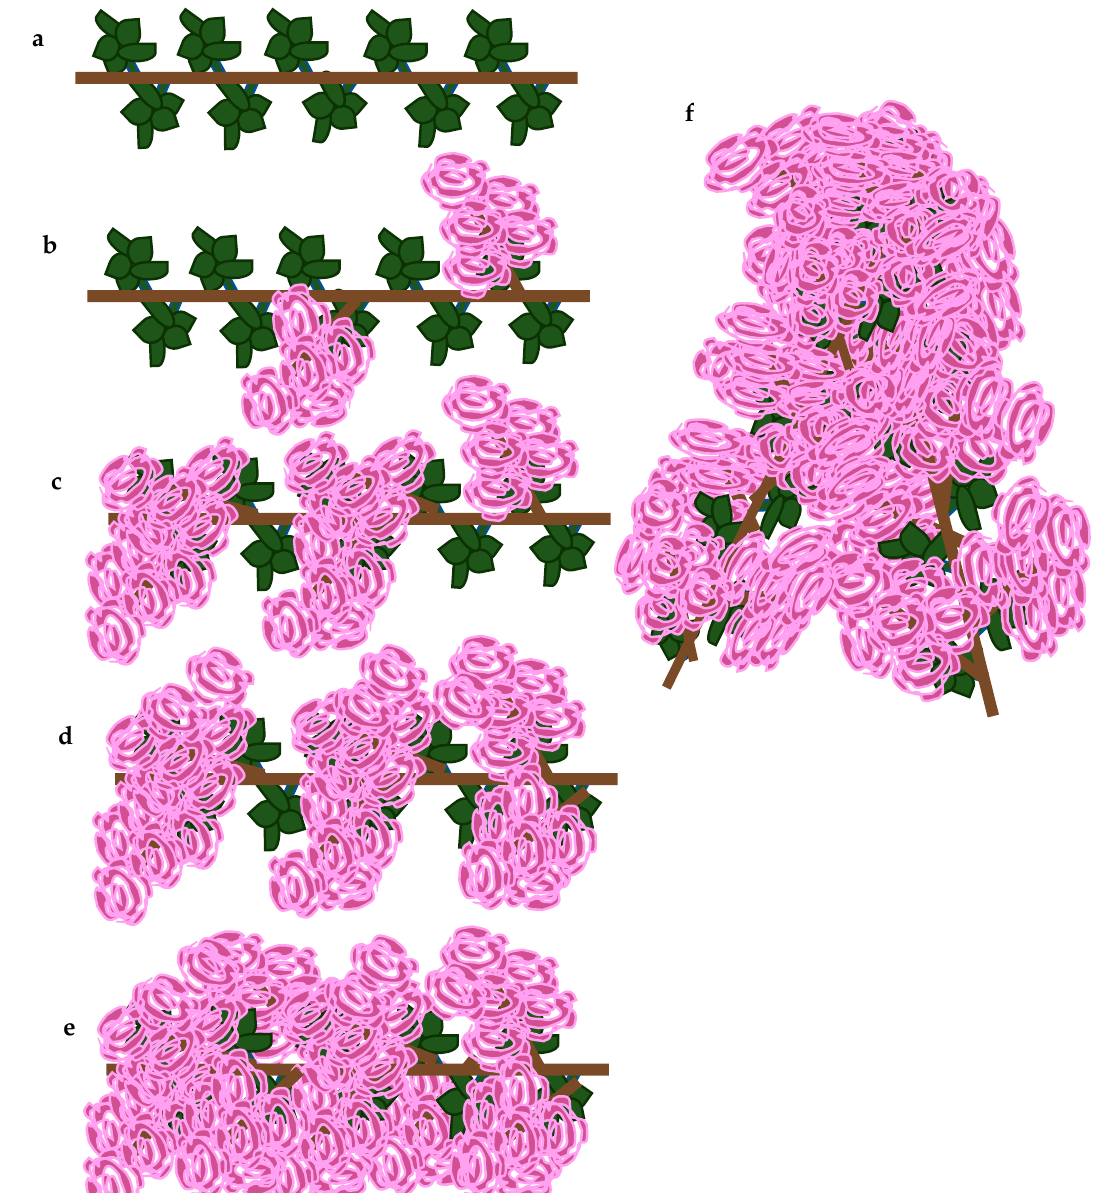
Figure 4. The abundance of flowering on a scale 0–5, where: ( a ) 0—lack of flowers; ( b ) 1—some inflorescences on shoots; ( c ) 2—no more than 5 inflorescences on 1 m of shoot, poorly flowering; ( d ) 3—inflorescences with numerous flowers, flowering with average abundance; ( e ) 4—more than 5 inflorescences on 1 m of shoot, the flowering plentiful and long; and ( f ) 5—exceptionally plentiful and long flowering, the flowers densely cover the plant.